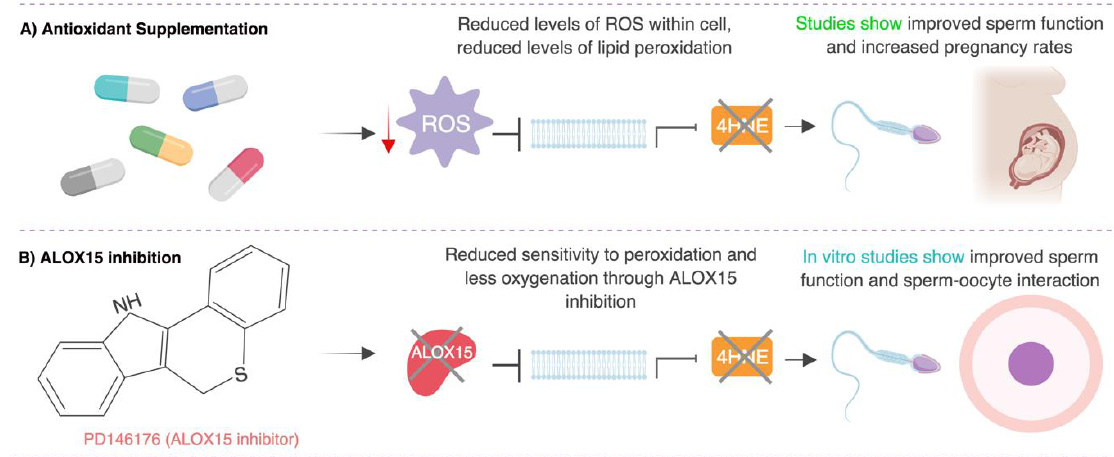
Figure 2. Potential strategies to protect human spermatozoa against oxidative stress. This model explores two strategies to protect against oxidative stress: antioxidant supplementation and arachidonate 15-lipoxygenase (ALOX15) inhibition. ( A ) Antioxidant supplementation has been shown to reduce levels of ROS, hence lipid peroxidation may be prevented, or its products scavenged, allowing sperm function to be improved. ( B ) ALOX15 inhibition in human sperm has been demonstrated to reduce lipid peroxidation and improve sperm function and sperm-oocyte interaction in vitro. Figure created with BioRender.